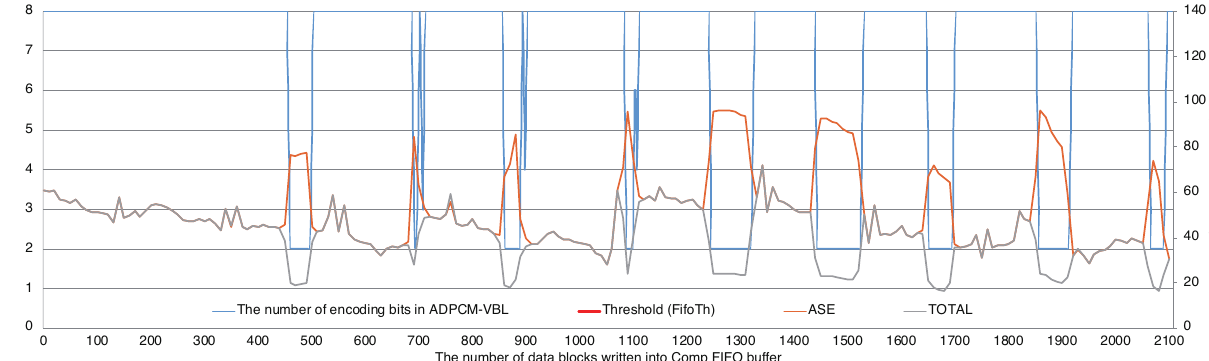
Figure 12. The number of encoding bits in ADPCM-VBL (M) and the compression ratios during the emulation.